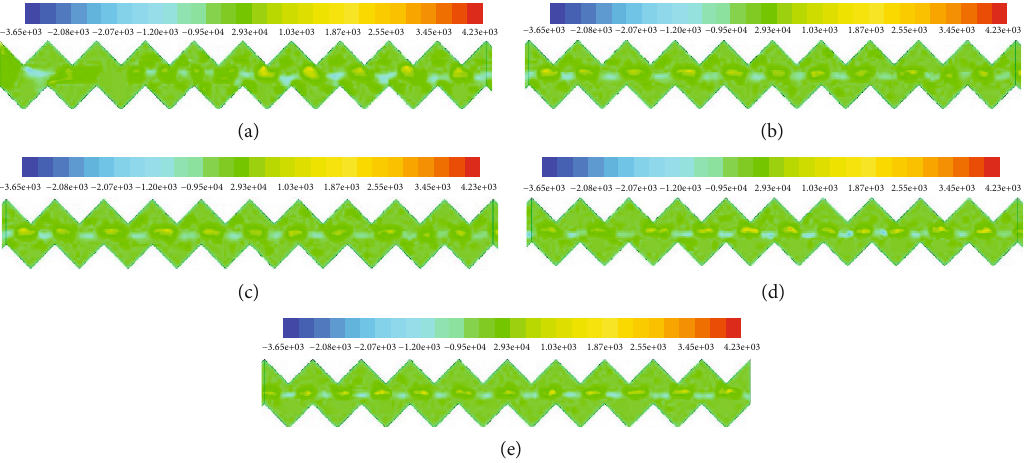
X = 0 mm to X = 20 mm ; (b) 1 1 = 80mm to X = 100 mm 1 1